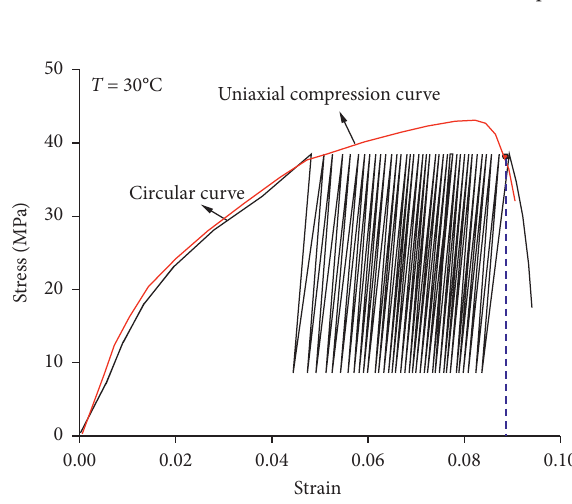
Figure 5: Comparison of attenuation functions.